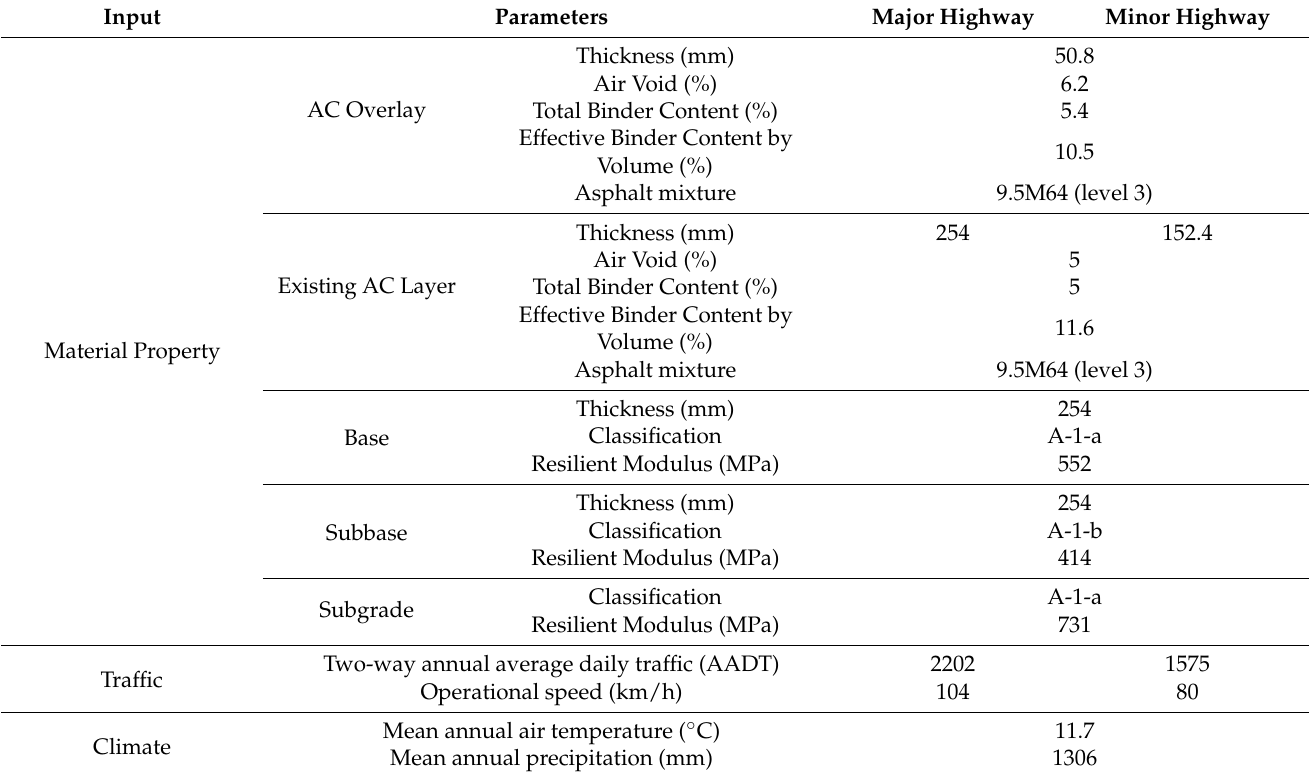
Table 2. Pavement structure and material inputs for Pavement